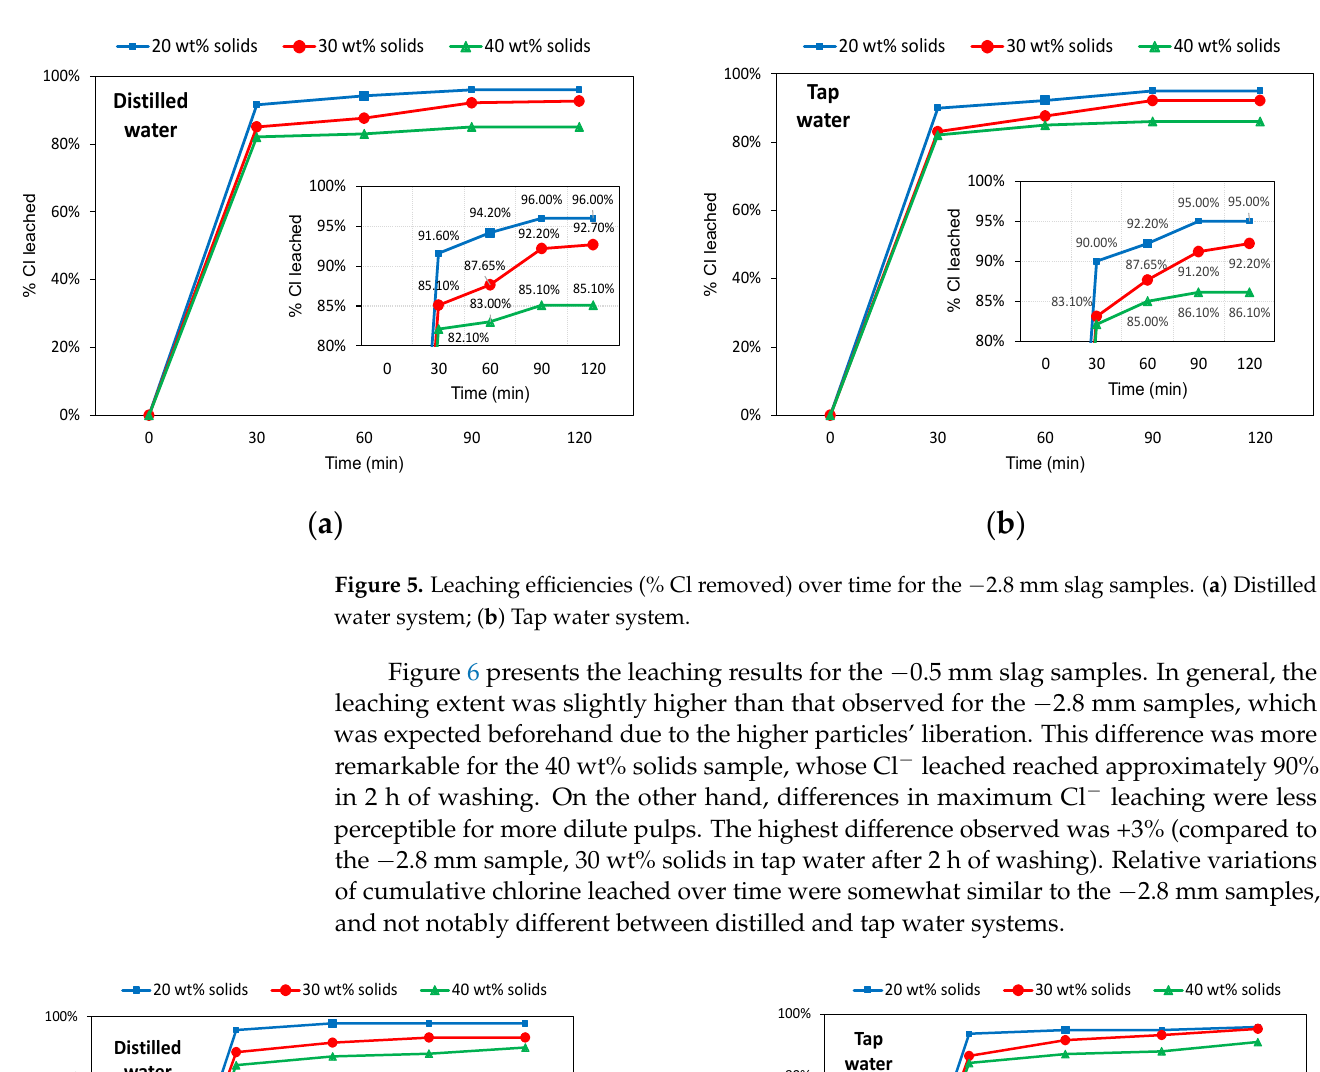
Figure 5. Leaching e ffi ciencies (% Cl removed) over time for the − 2.8 mm slag samples. ( a ) Distilled water system; ( b ) Tap water system.